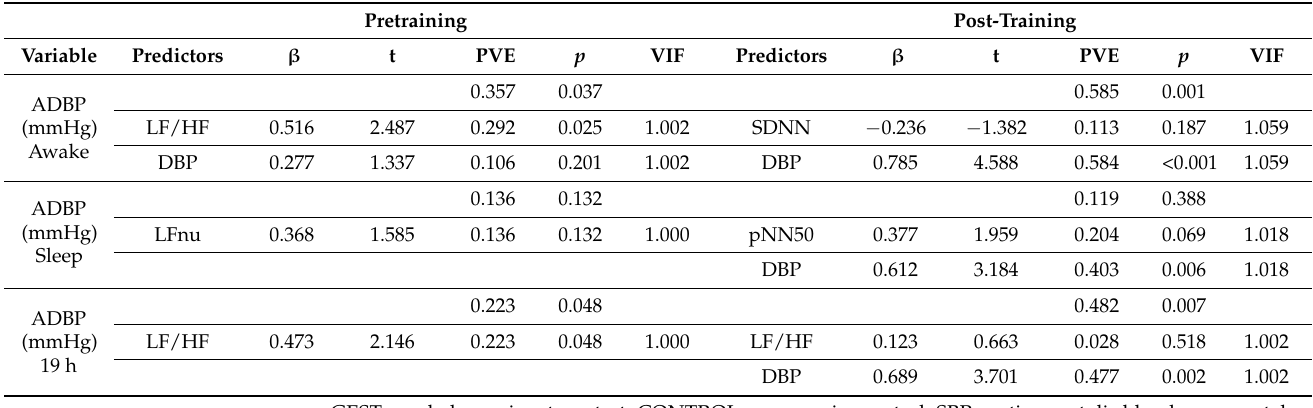
Table 5. Correlates of the ADBP response to the GEST versus CONTROL (PEH) before and after training over awake, sleep, and 19